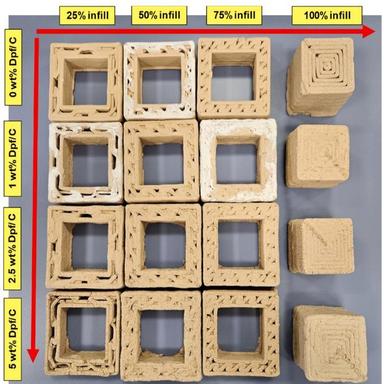
3DP walled structures of different Dpf/C structures with varying infill percentages and 50 × 50 mm cubes.